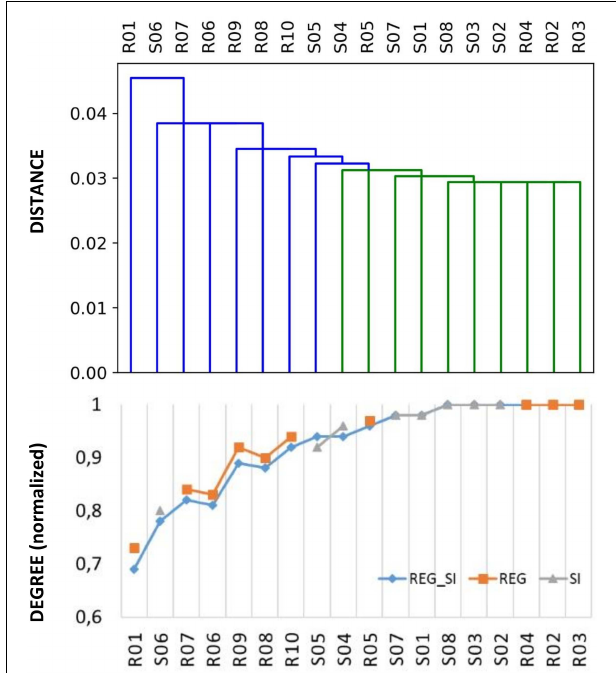
FIGURE 7 | The dendrogram on top shows how policies join in increasingly larger clusters when their distance (on the y-axis, see Section “Policy Networks and Clustering”) decreases from left to right. Bottom curves show that this behavior is well related to the degree of each policy (sum of the weights of its links) in the network of regional (REG; orange squares; see Figure 4 ), Solomon Island’s (SI; grey triangles; Figure 5 ) and regional and SI’s policies (REG_SI; blue dots; Figure 6 ). Policy degrees are normalised by the higher degree found in each network.